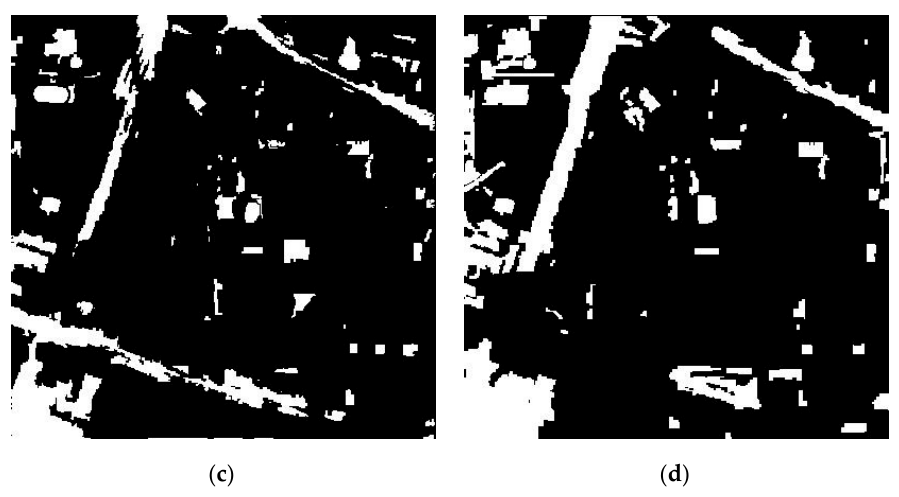
Figure 4. The change detection maps resulting from: ( a ) Otsu’s thresholding method, ( b ) threshold selection by clustering gray levels of boundaries, and ( c ) k -means clustering ( k = 2), compared with ( d ) the reference image, with L1 as the basis image in the first study area (scale = 100). According to the spatial resolution and the objects’ sizes in the bi-temporal images after preprocessing, the scale interval and step size increase were set as [10, 150] and 10, respectively. The results of the change feature analysis differ with the varying segmentation scales (Figure 5), and the optimal scale is around 100. Considering the multi-resolution characteristics of ground objects, multi- scale fusion is applied in the proposed method, and is realized by voting from the single-scale binary change maps. Figure 6 shows the accuracy of the k -means clustering ( k = 2) after the multi-scale fusion. The overall errors are the lowest when T f in Equation (13) is 0, which means that the optimal multi- scale fusion is the sum of the changes in all of the single-scale change detection maps.